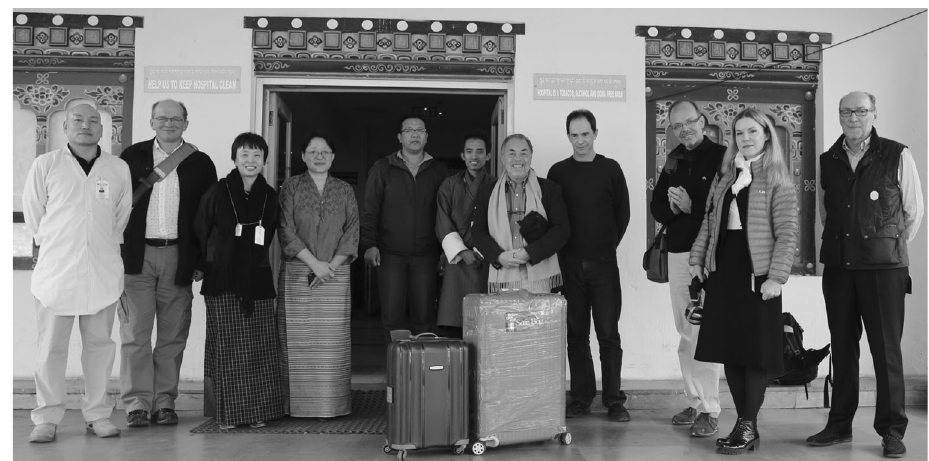
Fig. 2 The Geneva team delivering the system was greeted